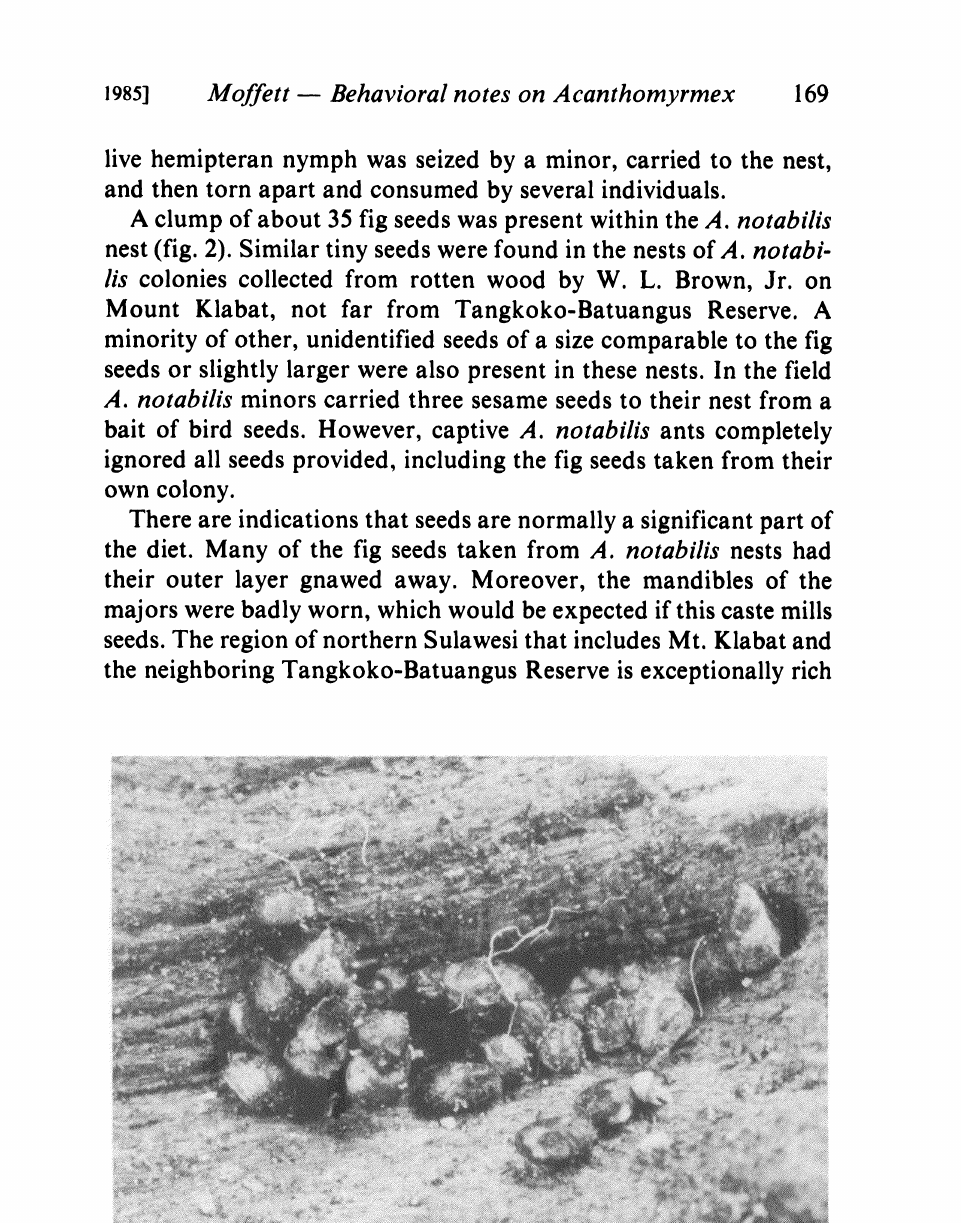
Figure 2. Fig seeds from Acanthomyrmex notabilis colony in